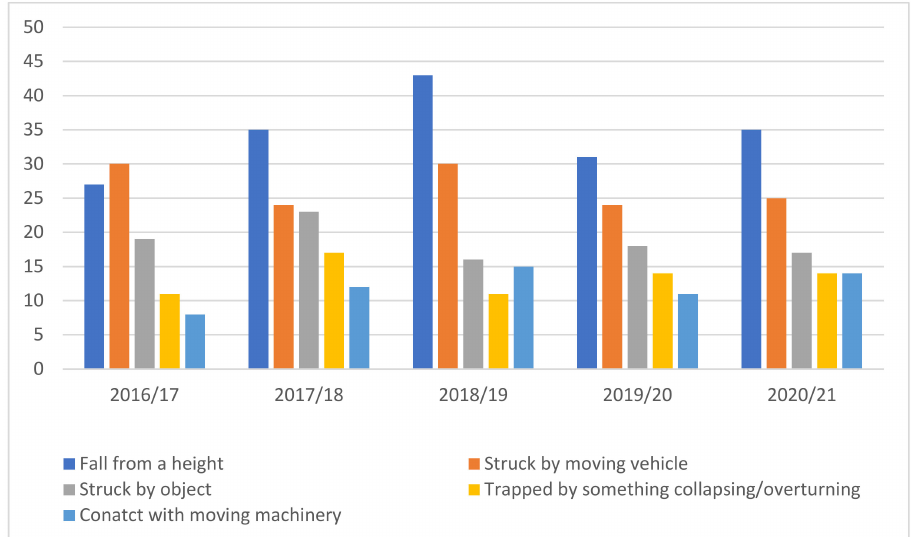
Figure 1. Leading types of fatal accidents for workers in the U.K.